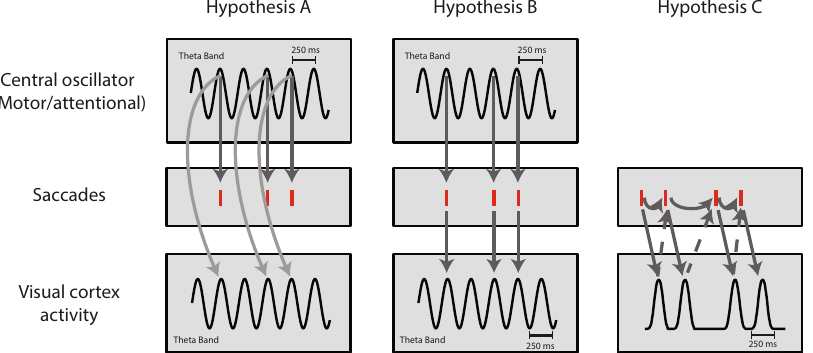
Figure 9. Alternative models explaining visual exploration dynamics. Hypothesis A Central theta oscillations drive saccades and the visual cortex independently; Hypothesis B, Central theta oscillations drive saccades. Saccades then drive visual activity through retinal image shifts or efferent activity; Hypothesis C, Saccades are generated by a self-paced mechanism and drive cortical rhythmicity through retinal image shifts or afferent activity. The visual transient caused by saccades’ first-order statistics constitutes the observed cortical theta rhythm (solid arrows).Visual cortex activity then drives saccades (dashed